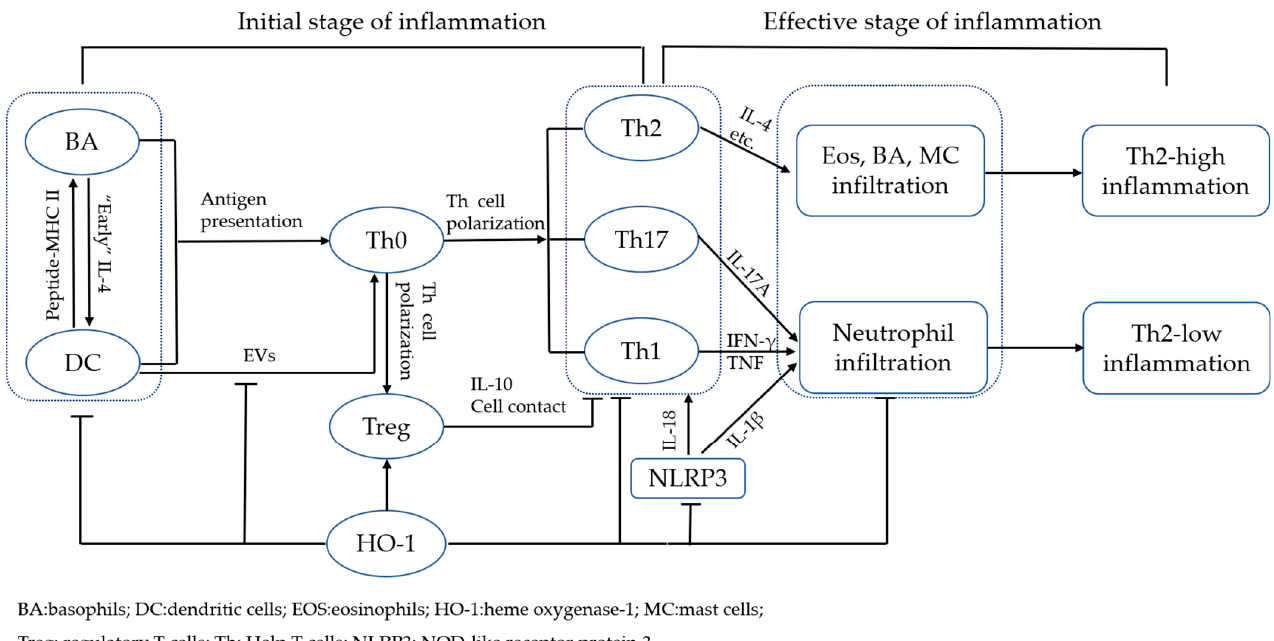
Figure 1. Multi-target effect of HO-1 and its immune regulation role in allergic airway inflammation. 1, HO-1 regulates APCs function and inhibits allergic airway inflammation at the initial stage: a, HO-1 and its end-product CO inhibit DC maturation by interfering with PAMPs and receptor binding, inhibit antigen presentation by impair fusion between late endosomes and lysosome, inhibit release of EVs from DCs and promote Treg polarization; b, BAs assist DCs participate in Th2 cells polarization by secreting “early” IL-4; BAs initiate Th2 polarization independently as APCs or BAs obtain MHC II-peptide complex from DCs through trogocytosis and subsequently initiate Th2 polarization;